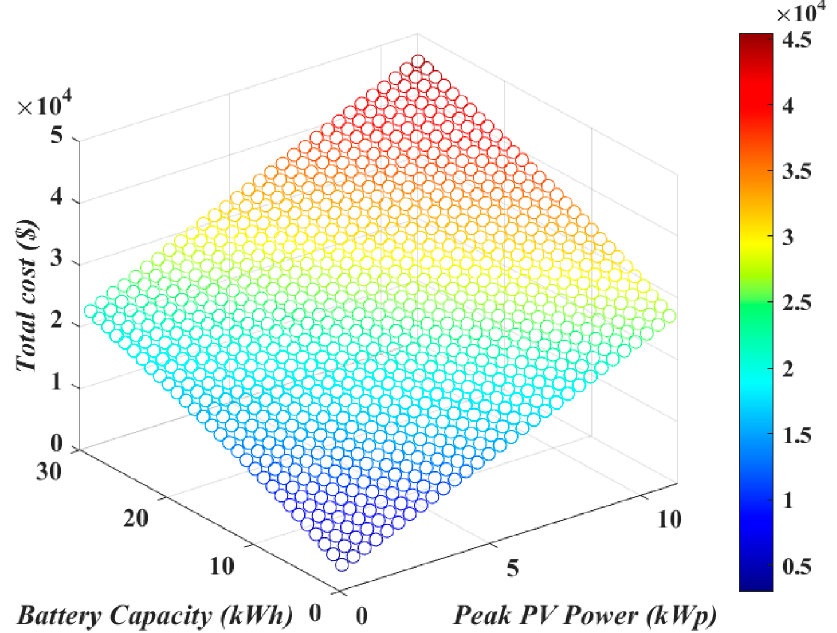
Figure 13. Total cost for a variety of PV-battery system combinations to supply a commercial base station in Aalborg.